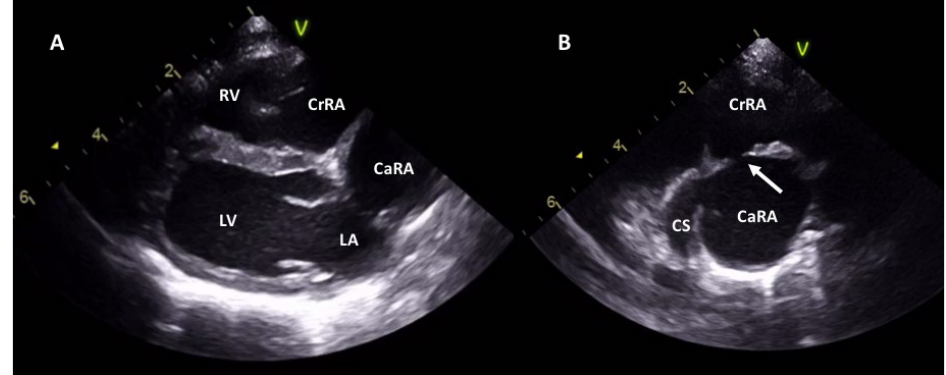
Figure 1. Two-dimensional echocardiographic images of case 1. Right parasternal long axis view ( A ), and right parasternal oblique view focused on the right atrium and caudal vena cava ( B ) showing the right atrium divided by a membrane into two chambers: the caudal chamber (CaRA) and cranial chamber. The two chambers communicate through a small perforation (white arrow). In figure B, we can notice the coronary sinus entering the CaRA. CaRA: caudal right atrium chamber; CrRA: cranial right atrium chamber; CS: coronary sinus; LA: left atrium; LV: left ventricle; RV: right ventricle. Table 1. Echocardiographic measurements of case 1 before and after the procedure. Before the Procedure After the Procedure